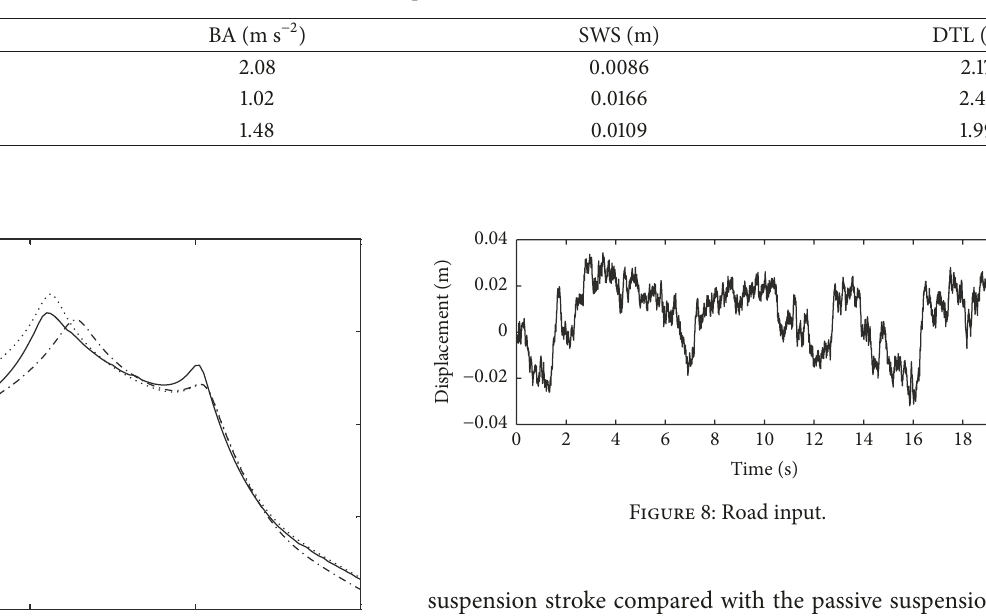
Table 4: RMS values of time responses to a random excitation.